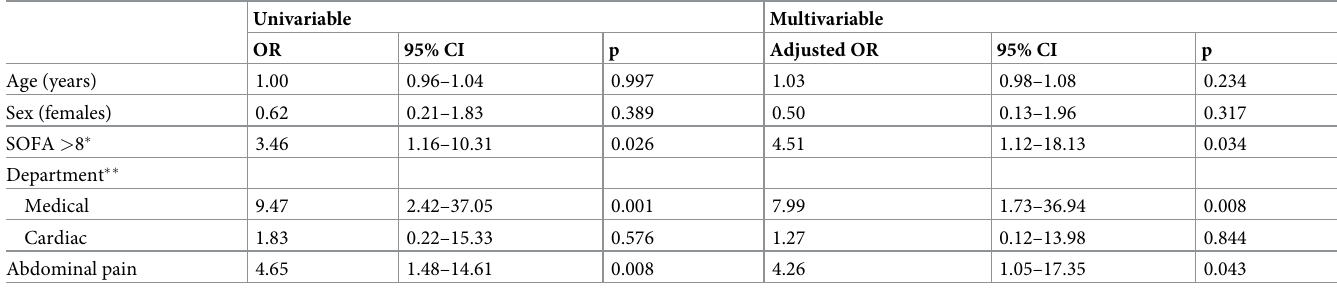
Within the study cohort, the non-survivor group had a higher SOFA score at the time of the NOMI diagnosis than did the survivor group. Organ failure is a dynamic process, and the degree of dysfunction may vary over time [13, 14]. The SOFA score, which is widely used for describing organ dysfunction in critically ill patients, is composed of scores from six organ sys- tems, and each score ranges from 0–4 according to the degree of dysfunction [14, 15]. Previous studies have shown that a high SOFA score is an independent risk and prognostic factor for NOMI [16, 17]. In a retrospective case-control study of severely burned patients, Soussi et al. evaluated potentially modifiable risk factors for the development of NOMI and found that a decreased cardiac index within the first 24 h and a higher SOFA score on day one were associ- ated with the development of NOMI [16]. Murata et al. evaluated prognostic factors for NOMI Table 4. In-hospital mortality predictors for the patients with